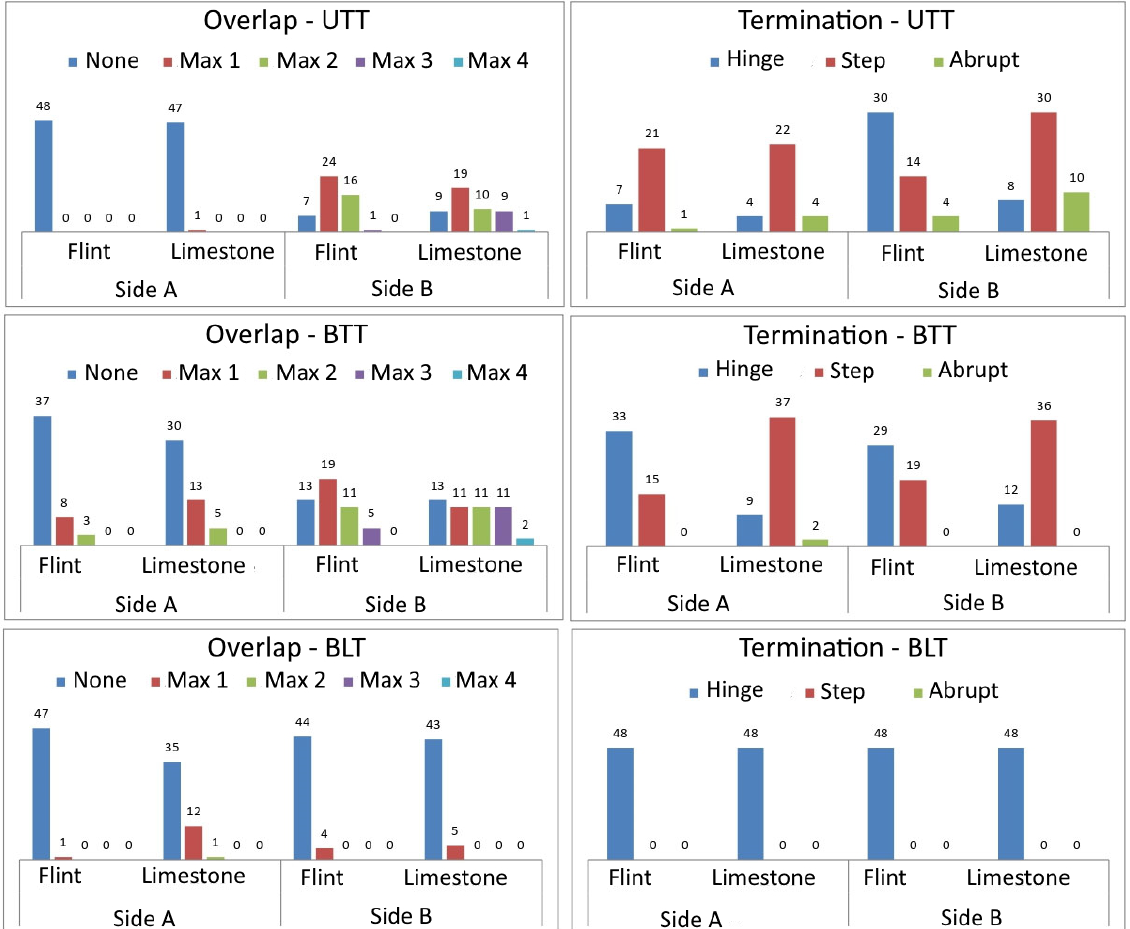
Figure 5. Histograms of overlapping and termination of micro-flake scars, for UTT, BTT and